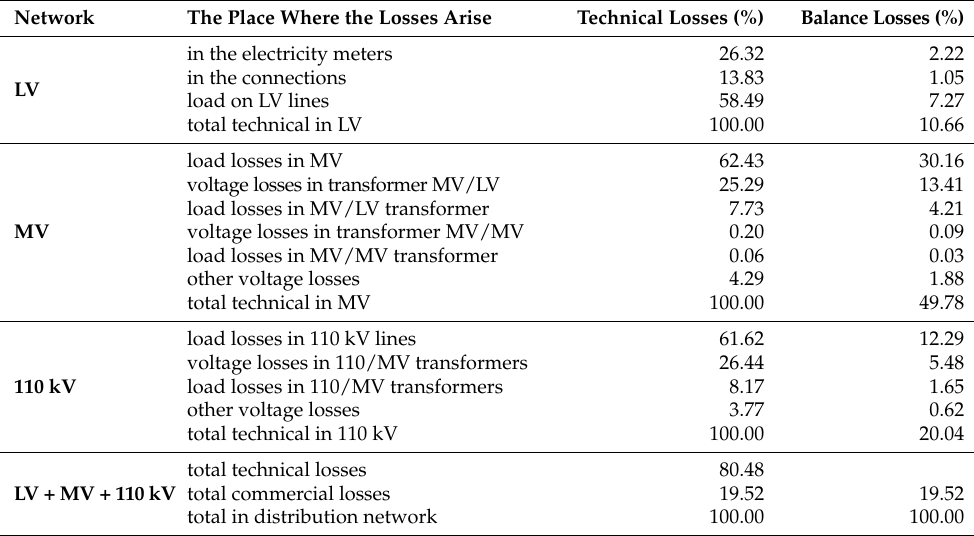
Table 1. Percentage distribution of electricity losses in the distribution